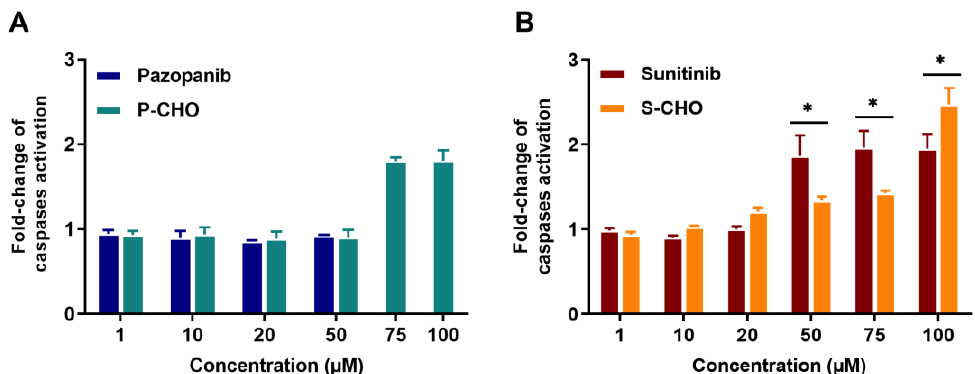
Figure 3. Activation of apoptosis in HepG2 cells exposed to pazopanib, sunitinib, and their respective aldehydes. Apoptosis was evaluated in HepG2 cells by measuring caspases 3 and 7 activity in the presence of pazopanib or P-CHO ( A ) and sunitinib or S-CHO ( B ). Results are given as mean and standard deviation (s.d.) of fold-change of caspases activation compared to control. * p < 0.05 in comparing the parent molecule versus the aldehyde metabolite.